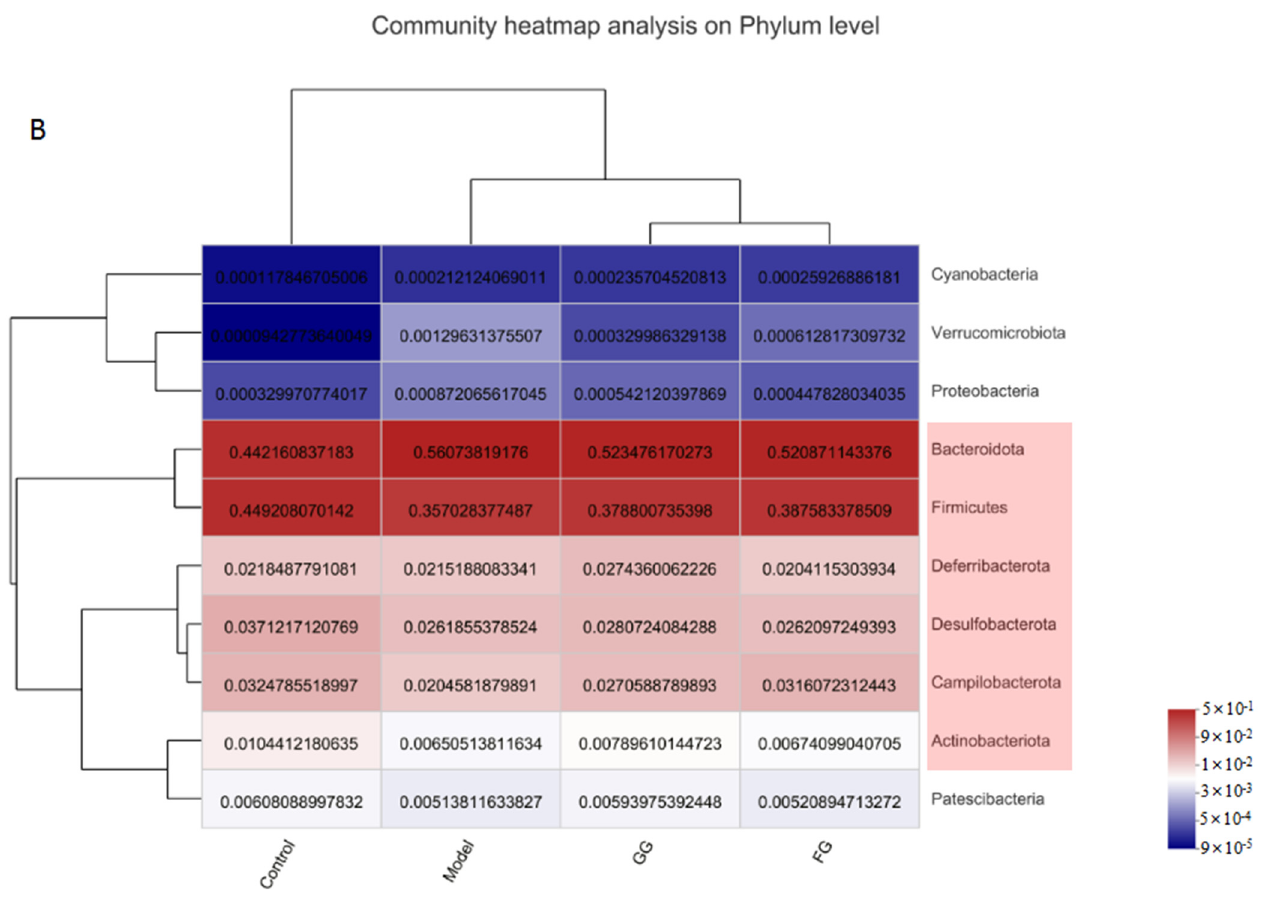
Figure 13. Changes in the relative abundance of cecal microflora at the phylum level in db/db mice ( n = 10). ( A ) community barplot analysis on Phylum level; ( B ) community heatmap analysis on Phylum level.